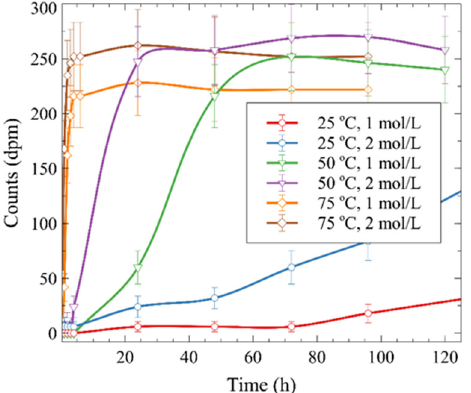
Figure 5. Activity of the decontamination solution depending on the time of contact with the resin. Solution volume—100 mL, resin volume—2 mL.